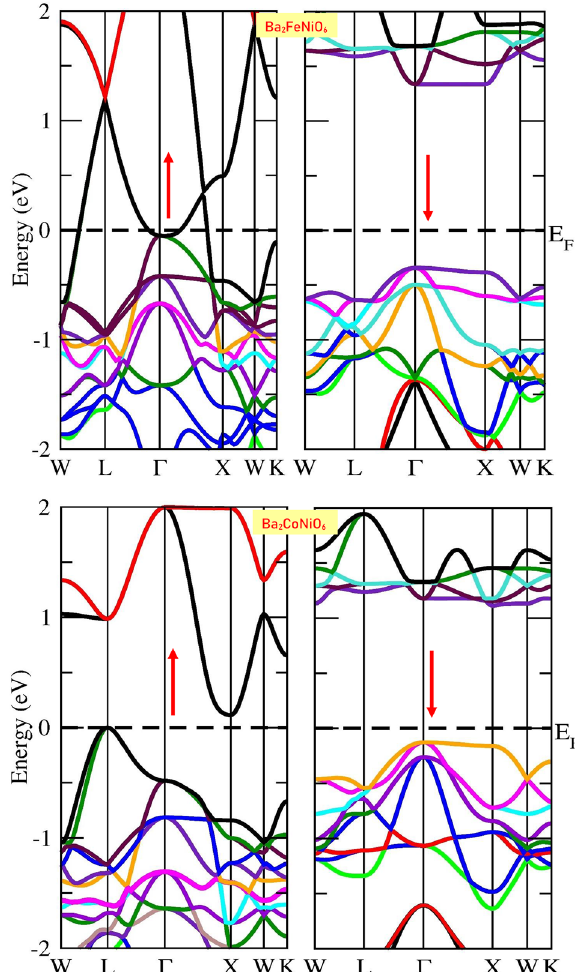
Figure 2. The spin-polarized band structure computed by employing GGA + mBJ approximation (the arrows are used to designate spin channels, ↑ for spin-up; ↓ for